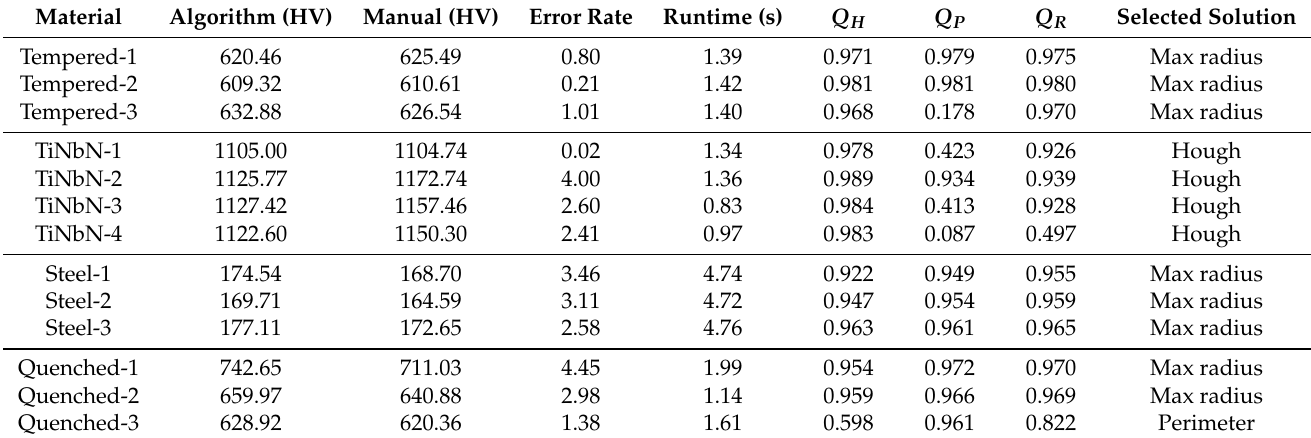
Table 1. Vickers hardness results with 5N applied force, where “Steel” corresponds to steel in its initial state, Q H to the quadrature index of the solution by Hough, Q P to the quadrature index of the solution by Perimeter and Q R to the quadrature index of the Local Maximum Radius.